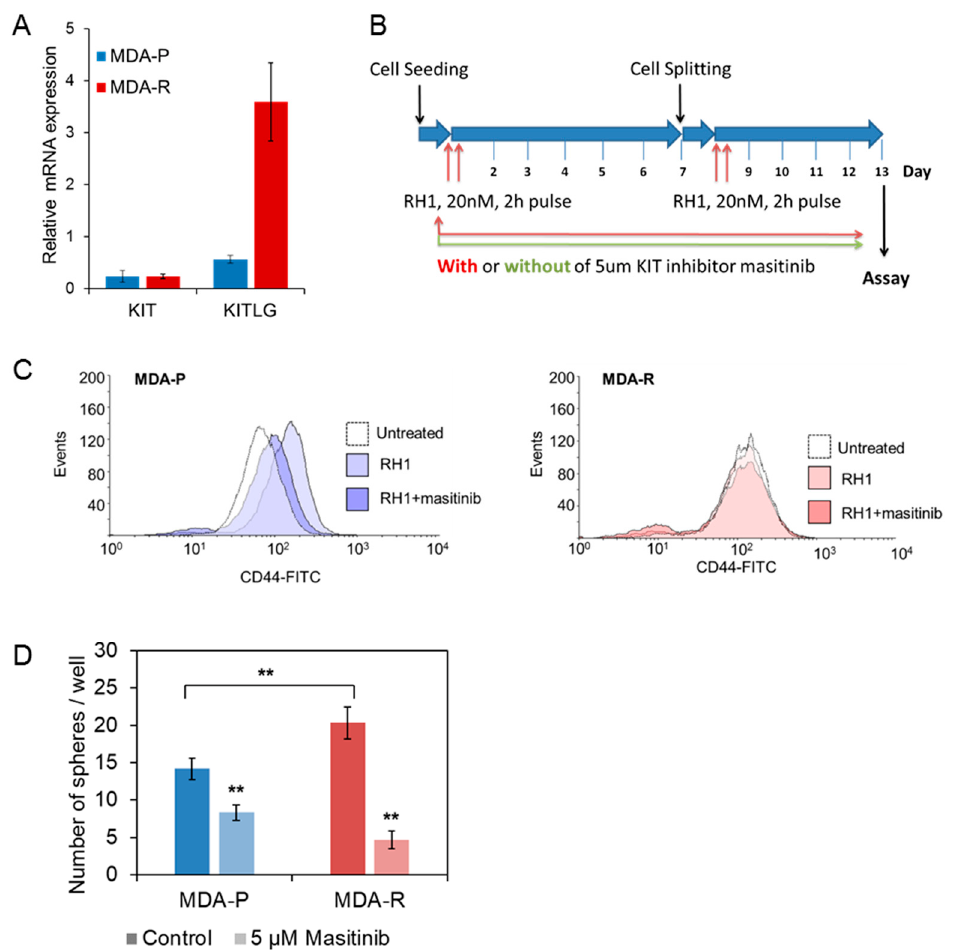
Figure 6. KIT inhibition attenuates MDA-P selection toward CSC induced by the double treatment with RH1. ( A ). Relative expression levels of KIT receptor and its ligand KITLG in MDA-P and MDA-R cells measured by RT-qPCR. The results are the mean of 3 independent experiments; bars are ± SD (ANOVA; * p < 0.05; ** p < 0.01). ( B ). Experimental time chart of cells short-time selection without and with KIT inhibition. ( C ). MDA-P (blue) or MDA-R (red) cells were pulse exposed or not exposed twice to 20 nM RH1 with or without of continuous treatment with KIT receptor inhibitor masitinib (5 µ m). After 13 days cells were stained with CD44-FITC antibody and analyzed by flow cytometry. ( D ). MDA-P and MDA-R cells were subjected to sphere forming assay with or without 5 µ M masitinib treatment. Spheres were stained with MTT dye and counted using ImageJ software. The results are the mean of 3 independent experiments, two replicates each; bars are ± SD (ANOVA; * p <0.05; ** p < 0.01).